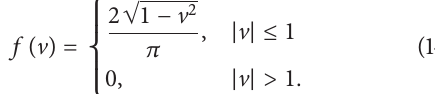
Table 5: The mean and standard derivation of A of the three extremes obtained by the presented method and by MCS with 5000 samples, respectively. Parameters are given as 𝑈/𝑈 𝑓 = 2.5 , 𝛿 0 = 100 , and 𝛿 1 = 50